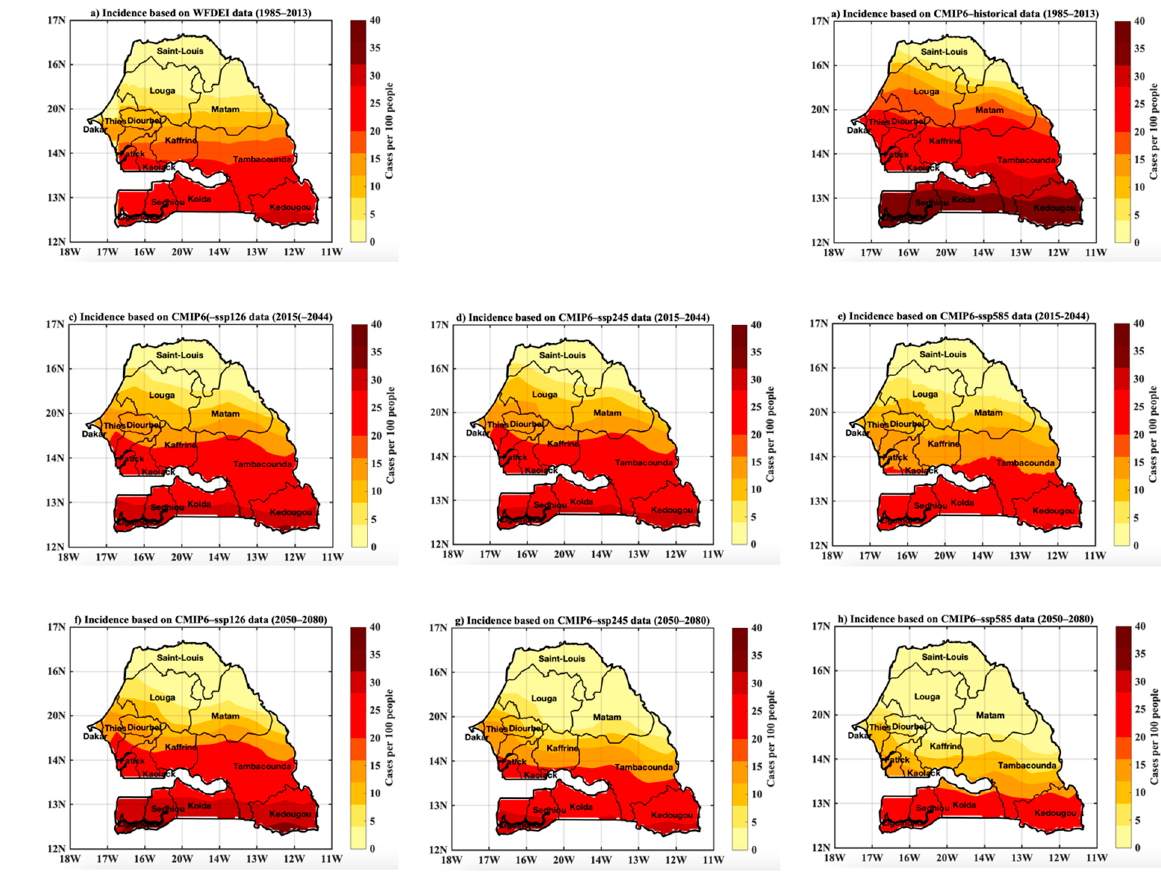
Figure 13. Spatial distribution of malaria incidence: ( a ) for the baseline period 1985–2013 and for simulations based on WFDEI data as reference, ( b ) for the historical period 1985–2013 and for simulations based, respectively, on scenarios SSP126, SSP245, SSP585 of the CMIP6 data, ( c – e ) for the near future 2015–2044 and ( f – h ) for the far future 2050–2080.